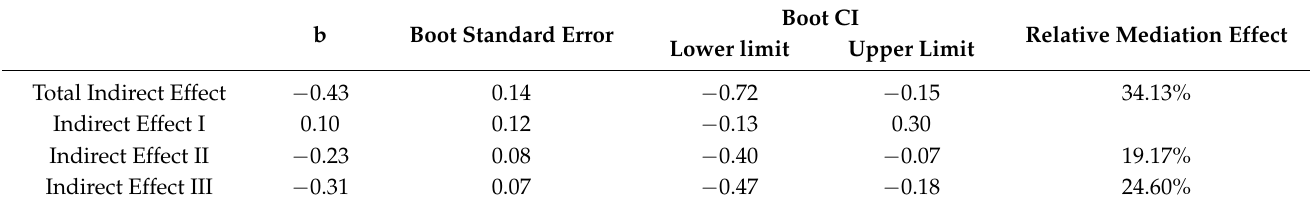
Table 3. The results of mediation analysis.